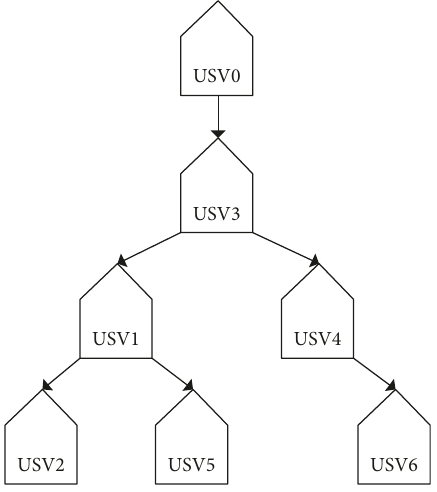
Figure 3: Directed communication topology. Table 2: The parameters of six follower USVs.